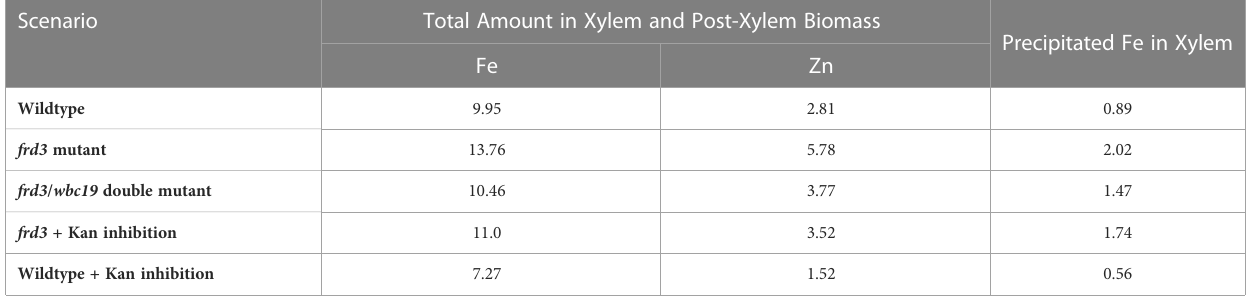
TABLE 6 Total biomass Fe, precipitated Fe, and Zn in biomass of the frd3 mutant, the double knockout ( frd3 and wbc19 ), and the frd3 mutant under Kan exposure at Day 10.